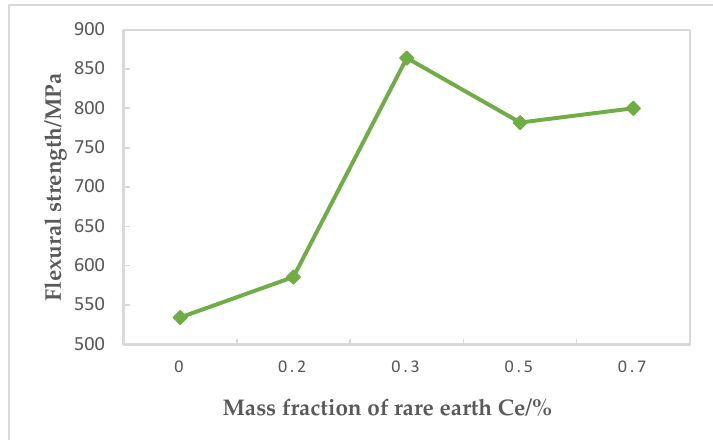
Figure 4. Effect of mass fraction of rare earth Ce on the flexural strength.